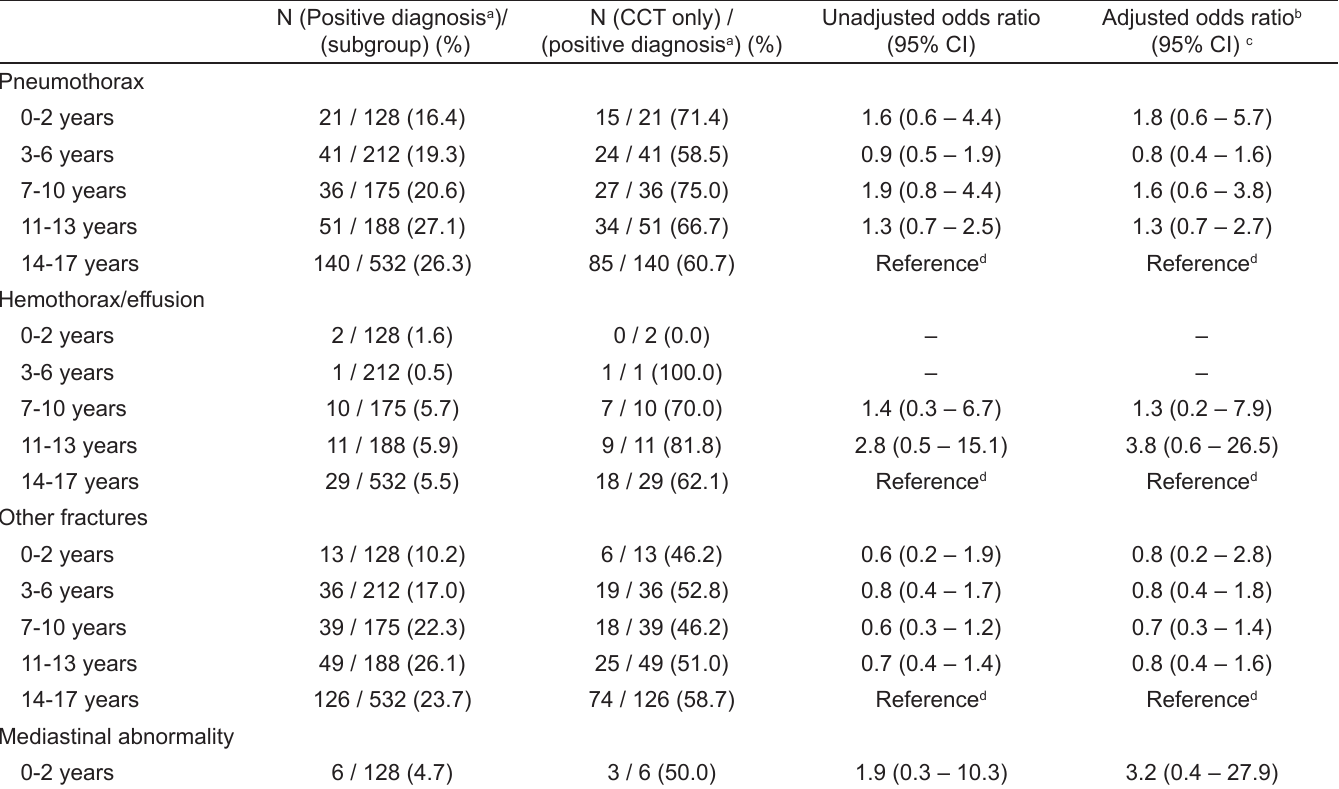
Table 3b. Association between age and positive chest computed tomography